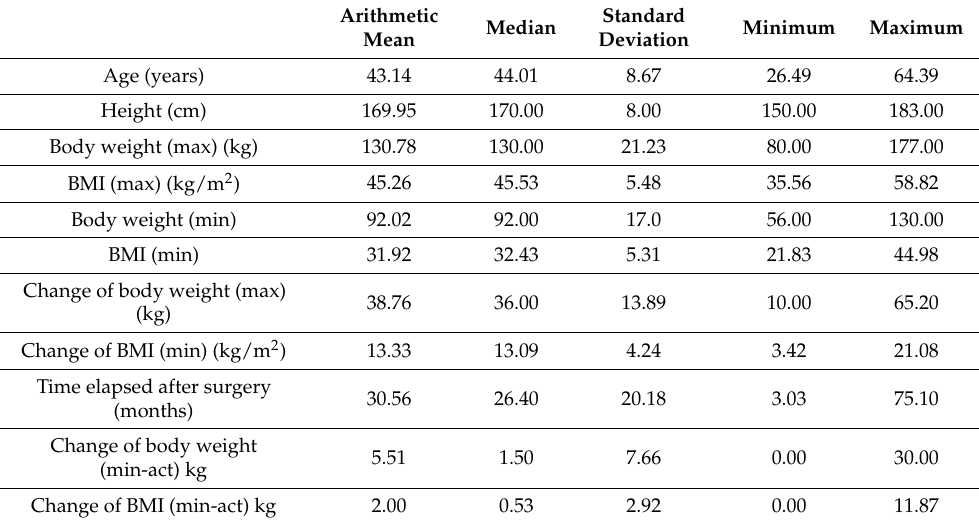
Table 4. Statistical analysis of the examined